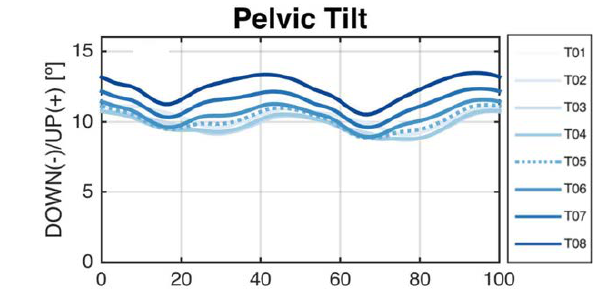
Fig. 1 Data curve during the walking exercise